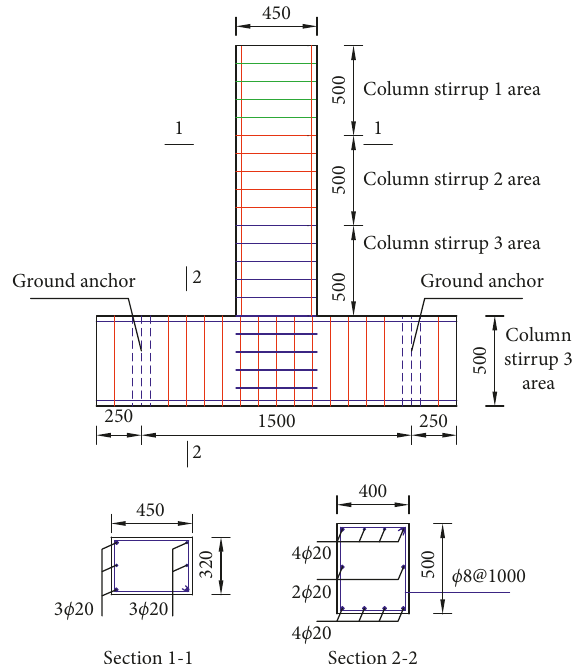
Figure 2: Size and reinforcement of the second group of test